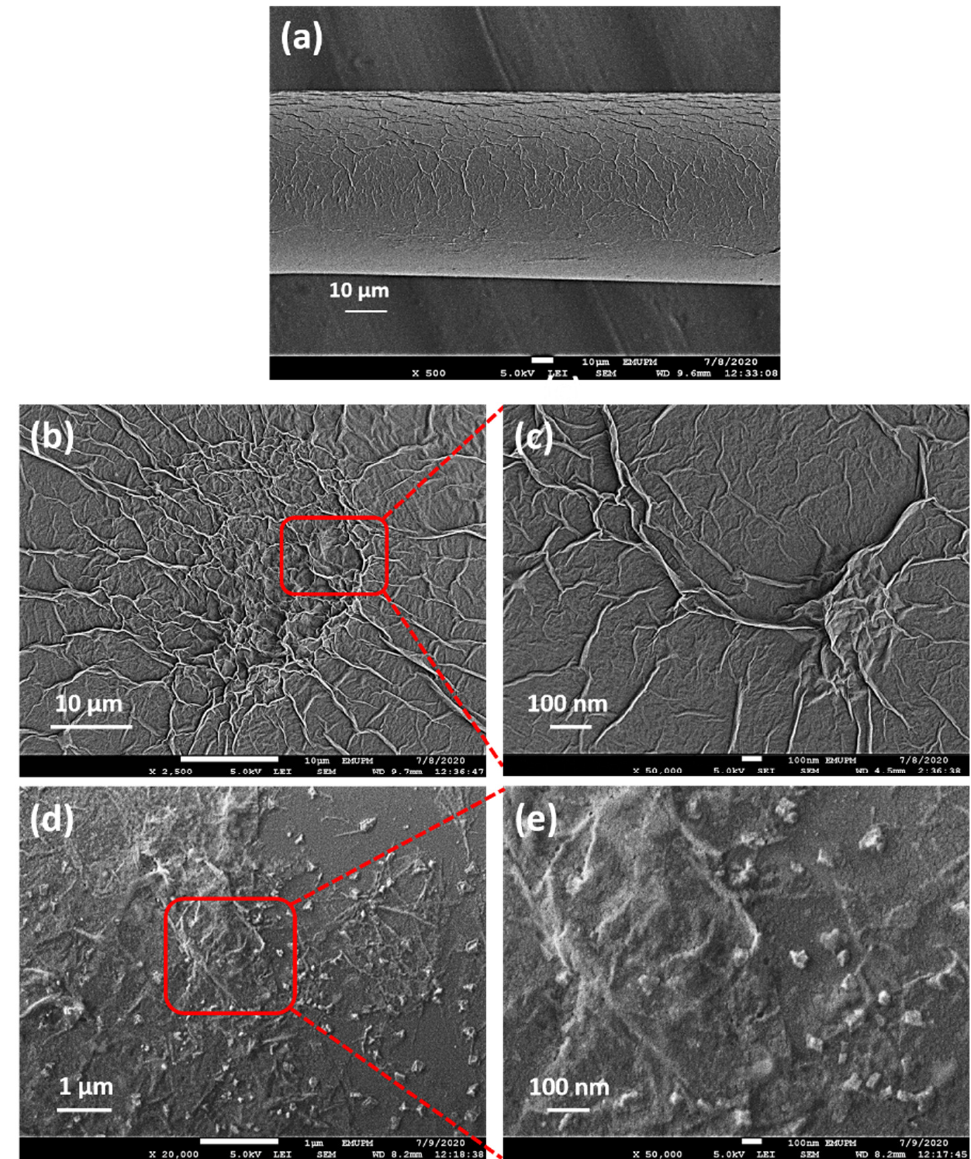
Figure 8. FESEM micrographs of ( a ) tapered MMF coated with Pd/GO composite, ( b , c ) GO, ( d , e ) Pd/GO nanocomposite.